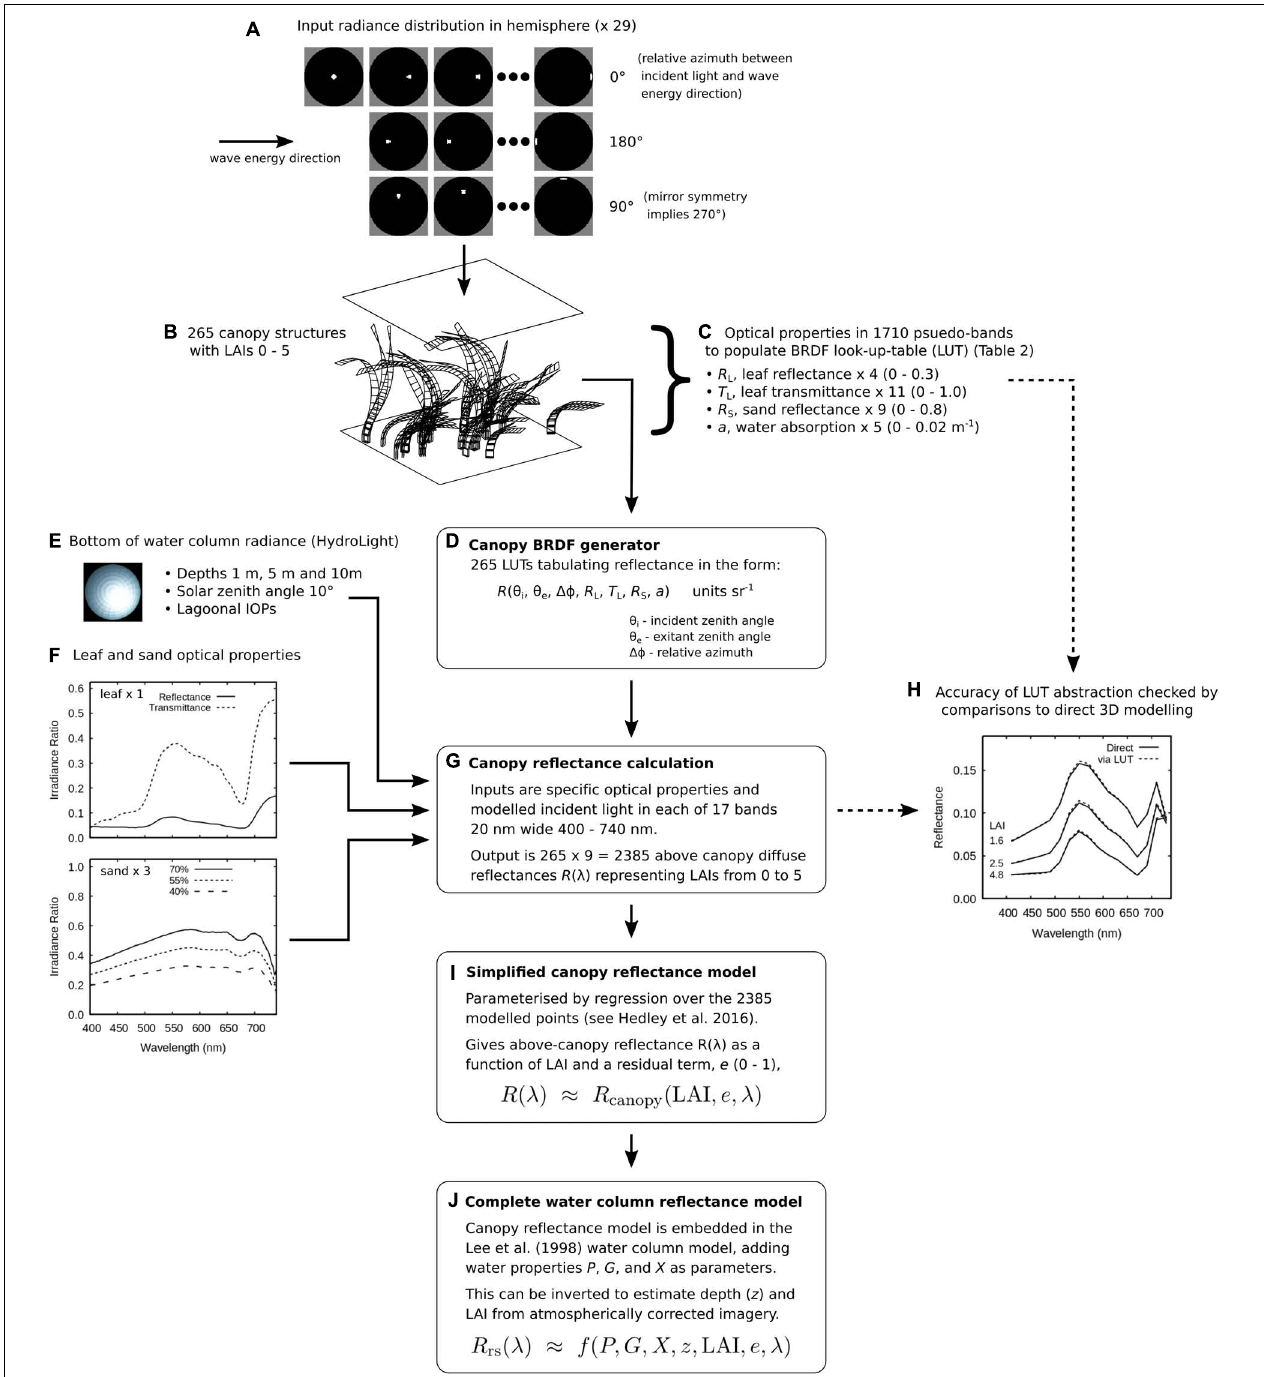
FIGURE 2 | Construction of the forward model. (A–C) A 3-dimensional canopy model is used to populate (D) a look-up-table, which combined with (E,F) material optical properties and incident radiance (G,H) generates above-canopy spectral reflectances. (I) A set of these reflectances parameterises a simplified bottom reflectance model which is (J) embedded in the Lee et al. (1998) semi-empirical water column model.